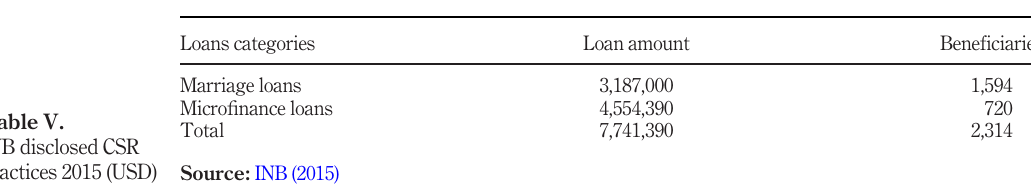
Table V. INB disclosed CSR practices 2015